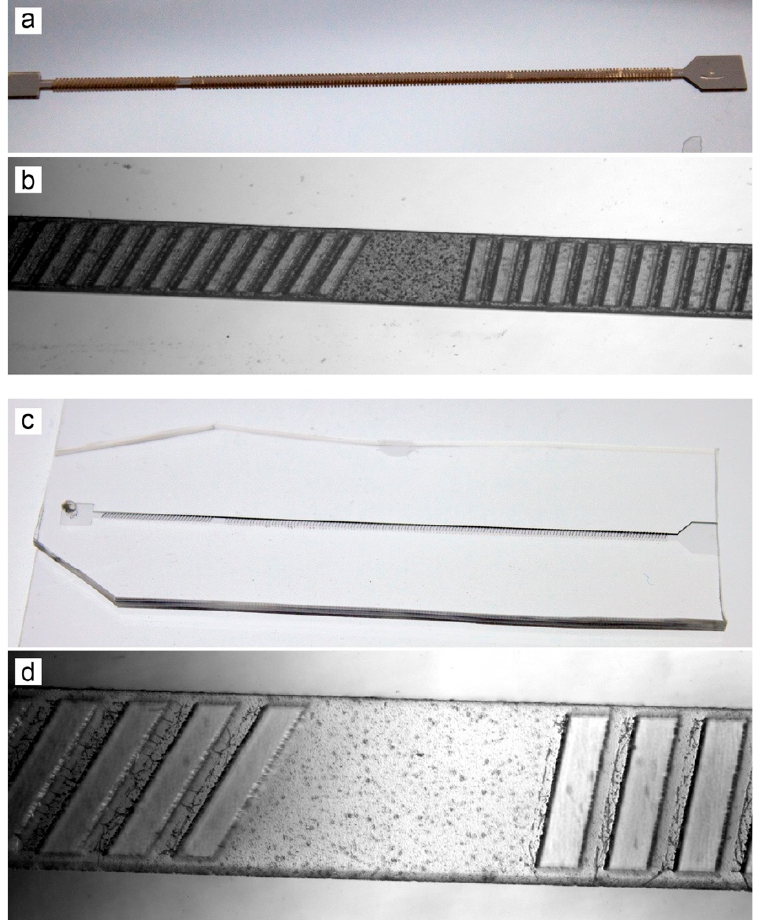
Figure 5. Hydrophoresis sorting device. ( a ) Multilayer master mold, following the final hard bake. ( b ) Microscope image of the master mold, showing excellent alignment of ridge features to the microchannel. ( c ) Completed hydrophoresis device after PDMS molding and plasma bonding to a glass slide. ( d ) Microscope image of a PDMS device, showing acceptable pattern fidelity to the